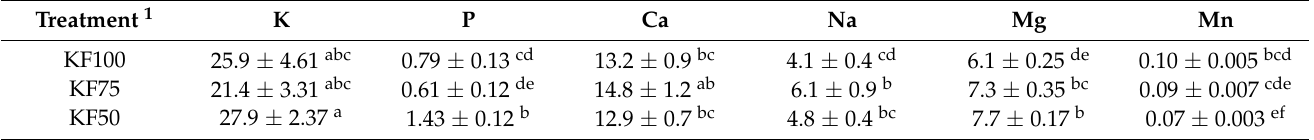
Table 1. Mineral/element content in tomatillo plants (g/kg dw) in the evaluation of the biofertilizing effect of Acinetobacter calcoaceticus UTMR2 in tomatillo plants ( Physalis ixocarpa Brot. cv. “c á scara morada”) at different doses of